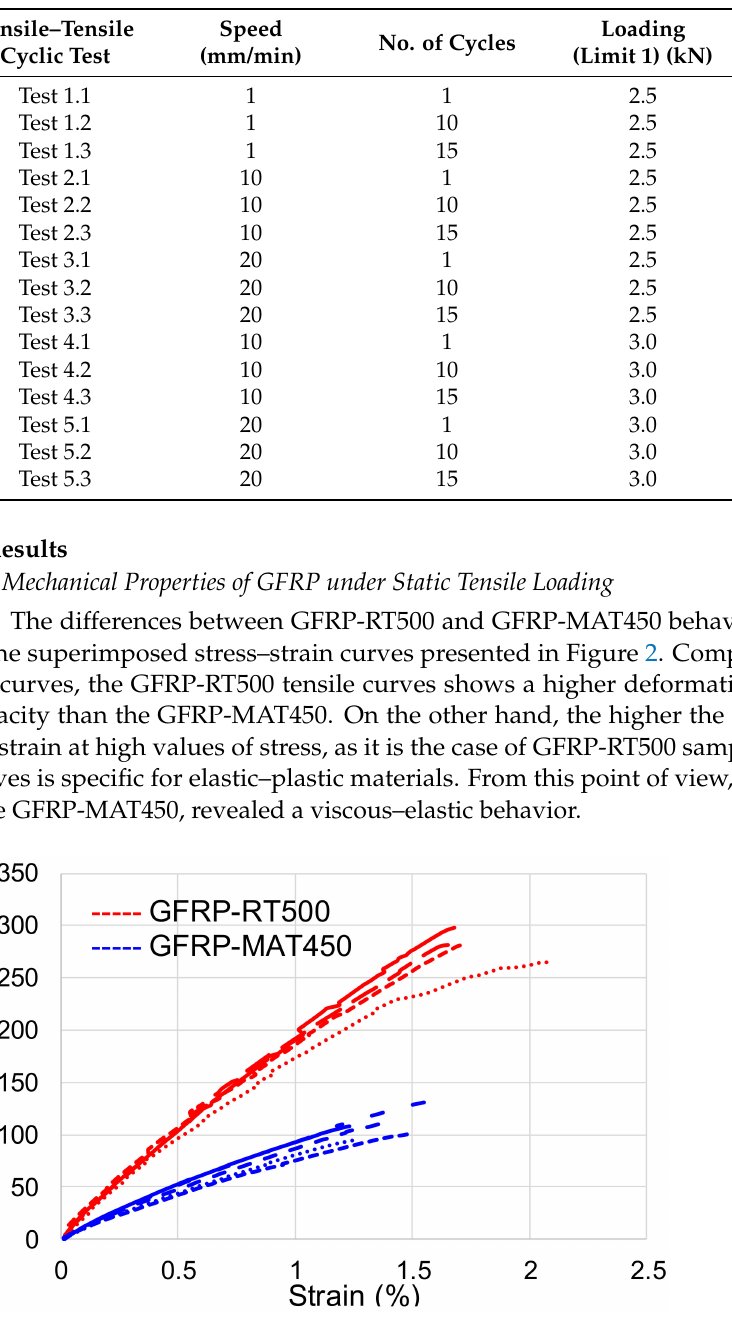
Table 3. The tensile–tensile cyclic design tests.